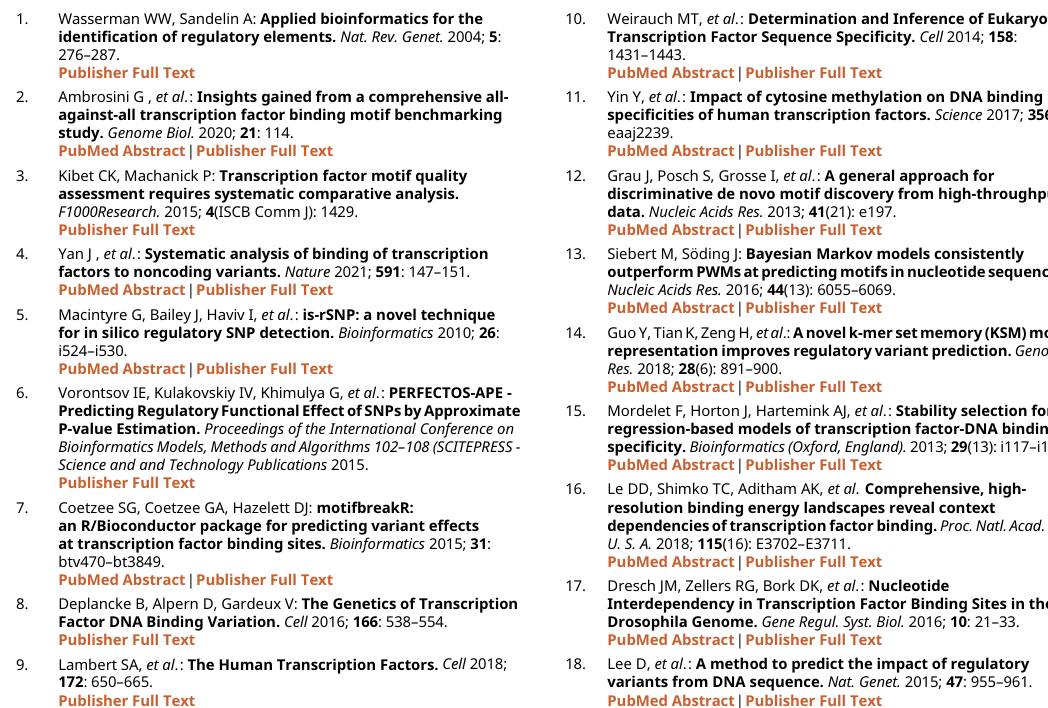
This project contains the following extended data: